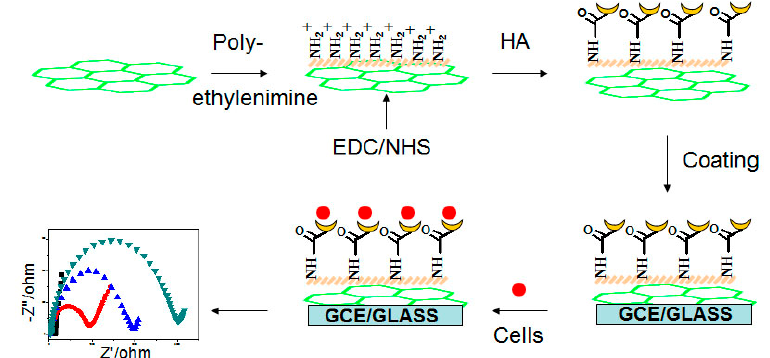
Figure 1. Procedure for preparing electrochemical cytosensor. EDC–1-(3-dimethylaminopropyl)-3-ethylcarbodiimide hydrochloride, NHS–N-hydroxysuccinimide, GCE– glass carbon electrode, HA–Sodium hyaluronate.